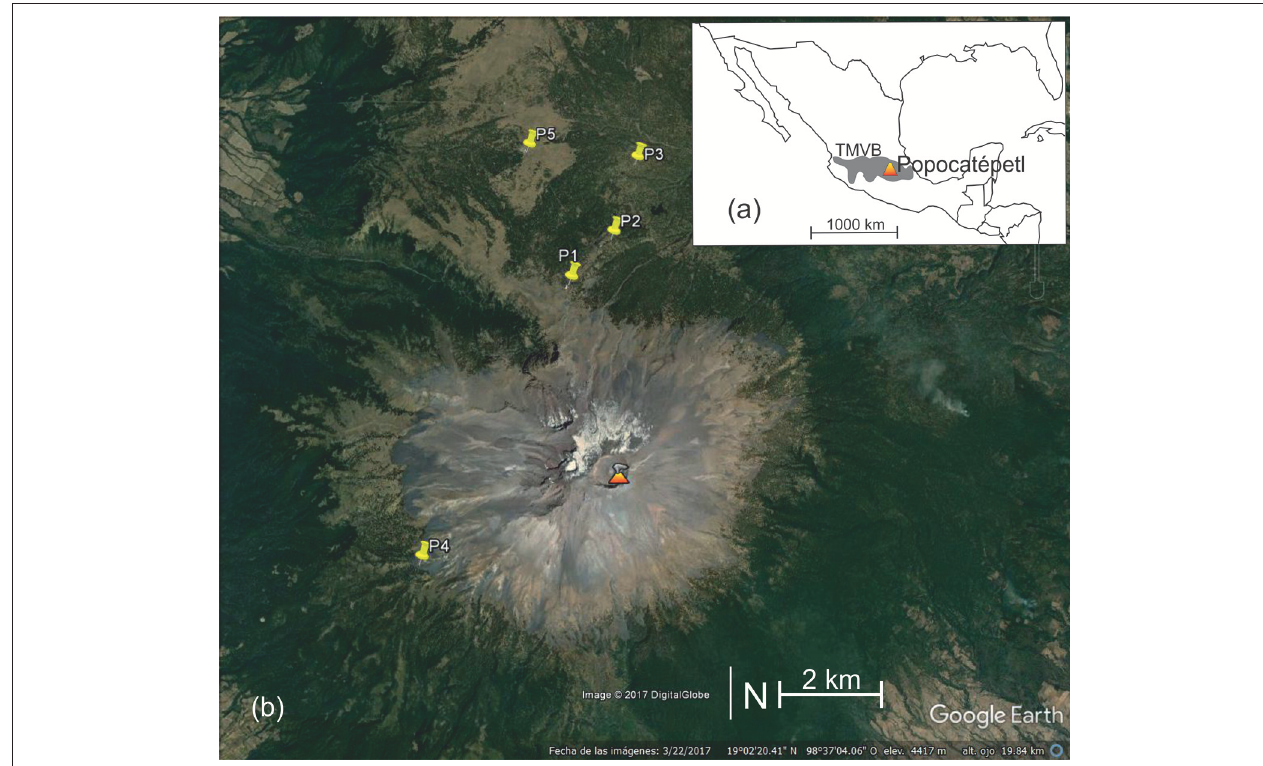
FIGURE 1 | (a) Location of Popocatépetl Volcano within the Trans-Mexican Volcanic Belt. (b) Satellite image of Popocatépetl Volcano showing the viewing points used in this